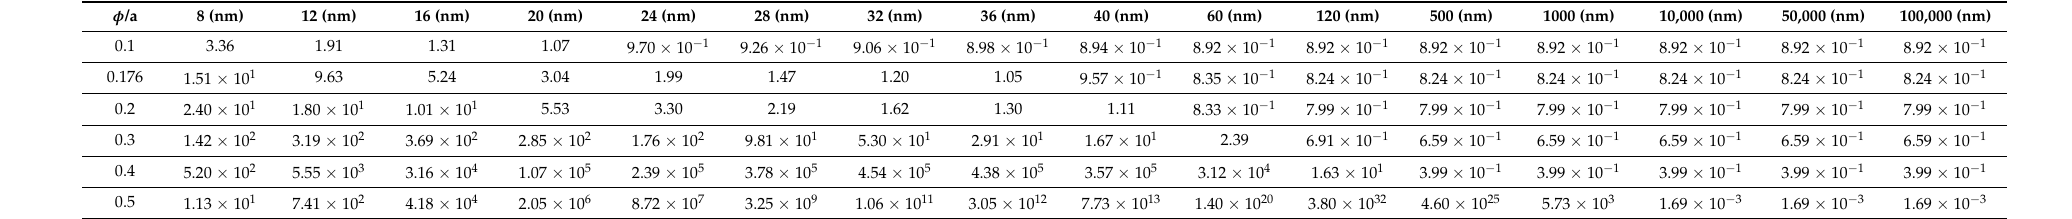
Table 2. DLVO total potential energies between two quartz particles at different solid fractions and particle sizes for the same quartz particles with the same particle